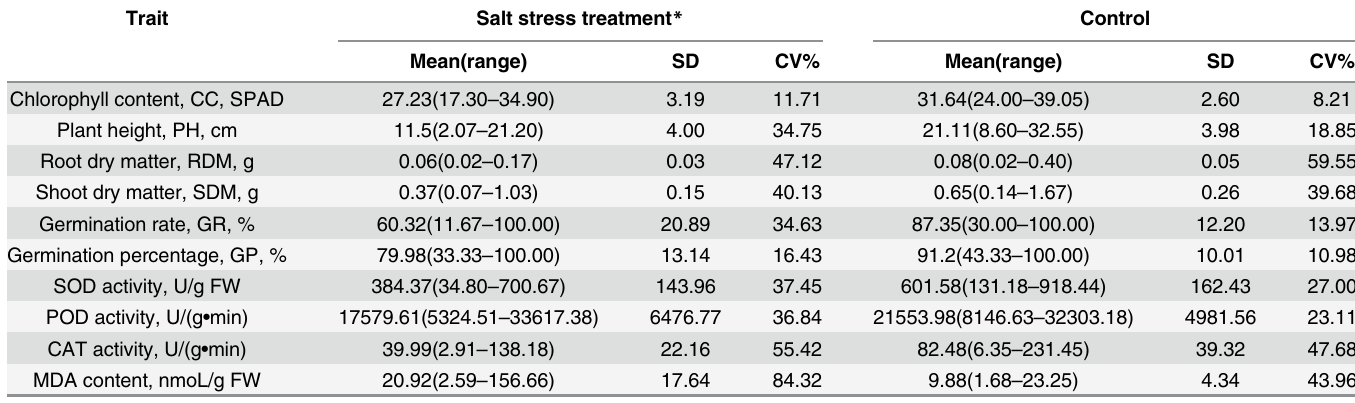
Table 1. Statistics of various traits related to salt tolerance with 150 mM NaCl (Salt stress treatment) or 0 mM NaCl (Control) in two-leaf seedling in cotton cultivars.